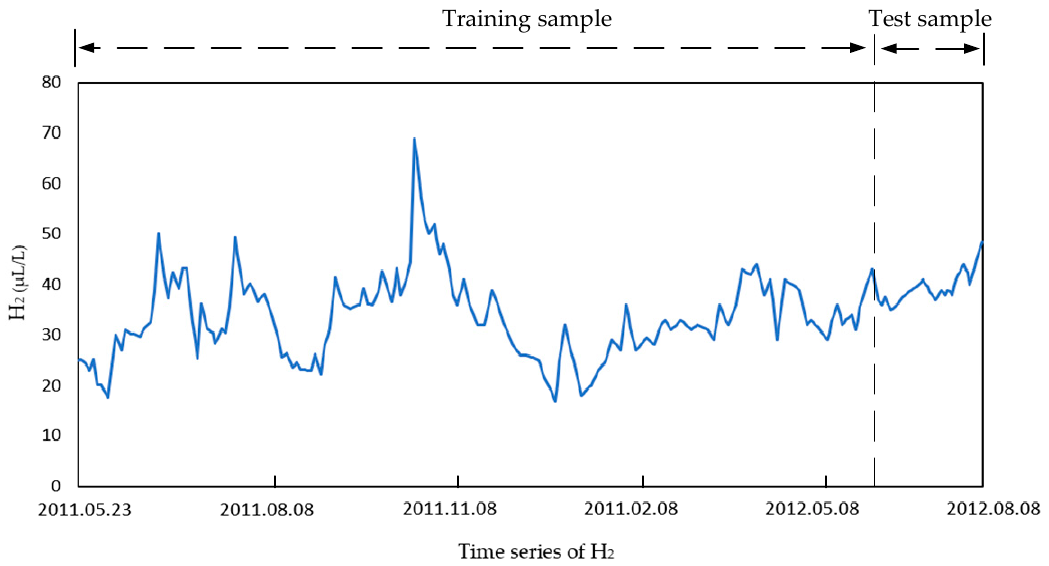
Figure 3. The original time series data of H 2 from 23 May 2011 to 8 August 2012 of 750 kV transformer of a substation of the state grid of China.